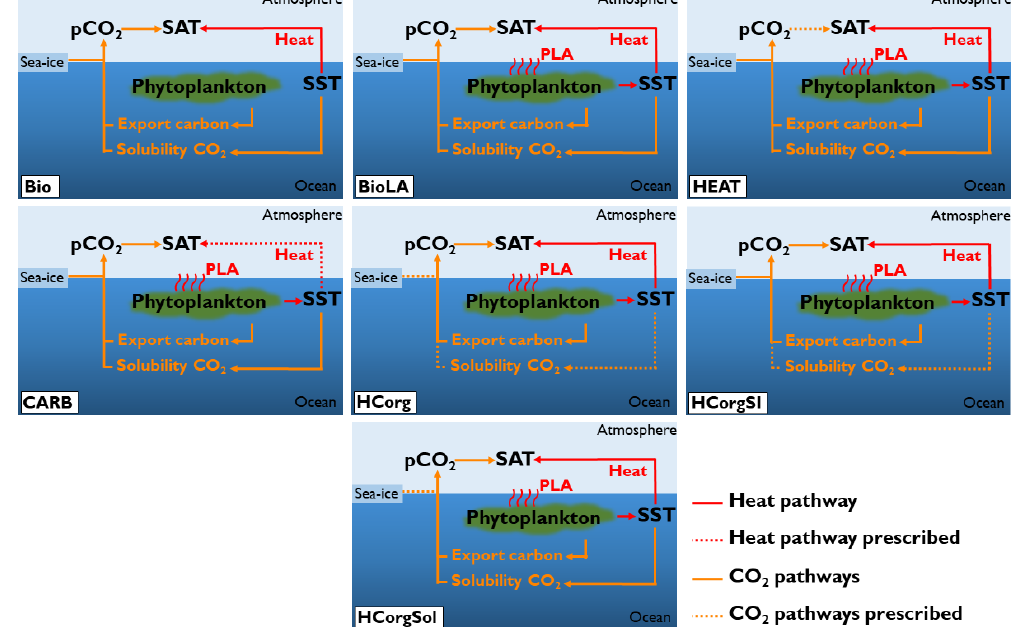
Figure 3. Sketch representing the climate pathways involved in the seven simulations (PLA: phytoplankton light absorption). Note that this figure is a simplification of Fig. 1; only the relevant pathways are represented. The name of the simulations are on the bottom left of each panel. The dashed arrows indicate the climate pathways prescribed. All the prescribed pathways are from the reference simulation Bio except the pathway between atmospheric CO 2 and SAT in CARB, which is prescribed from the simulation